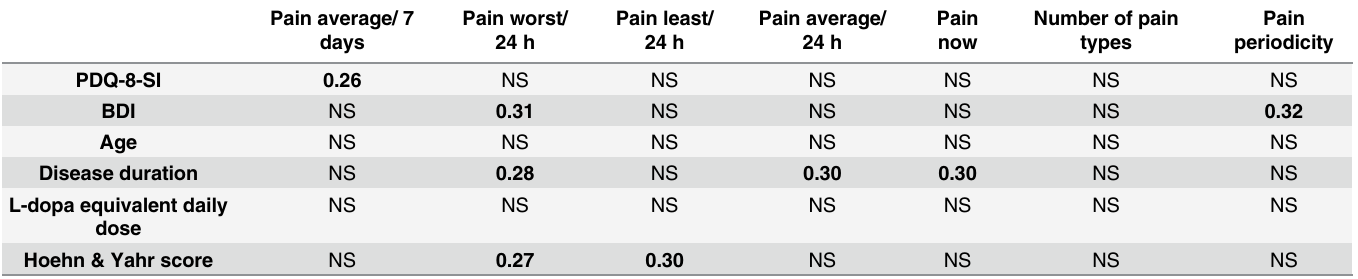
Table 6. Correlations of pain characteristics expressed as Spearman ’ s rank correlation coefficient with quality of life, depression, and selected variables of